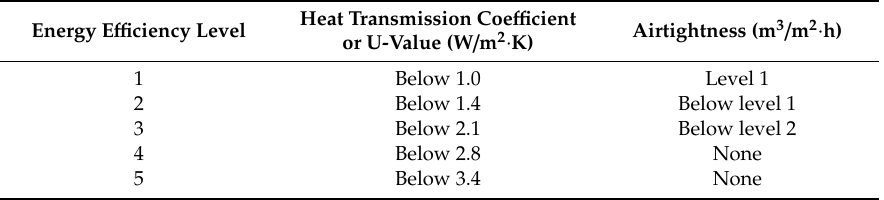
Table 1. Fenestration energy performance rating system in South